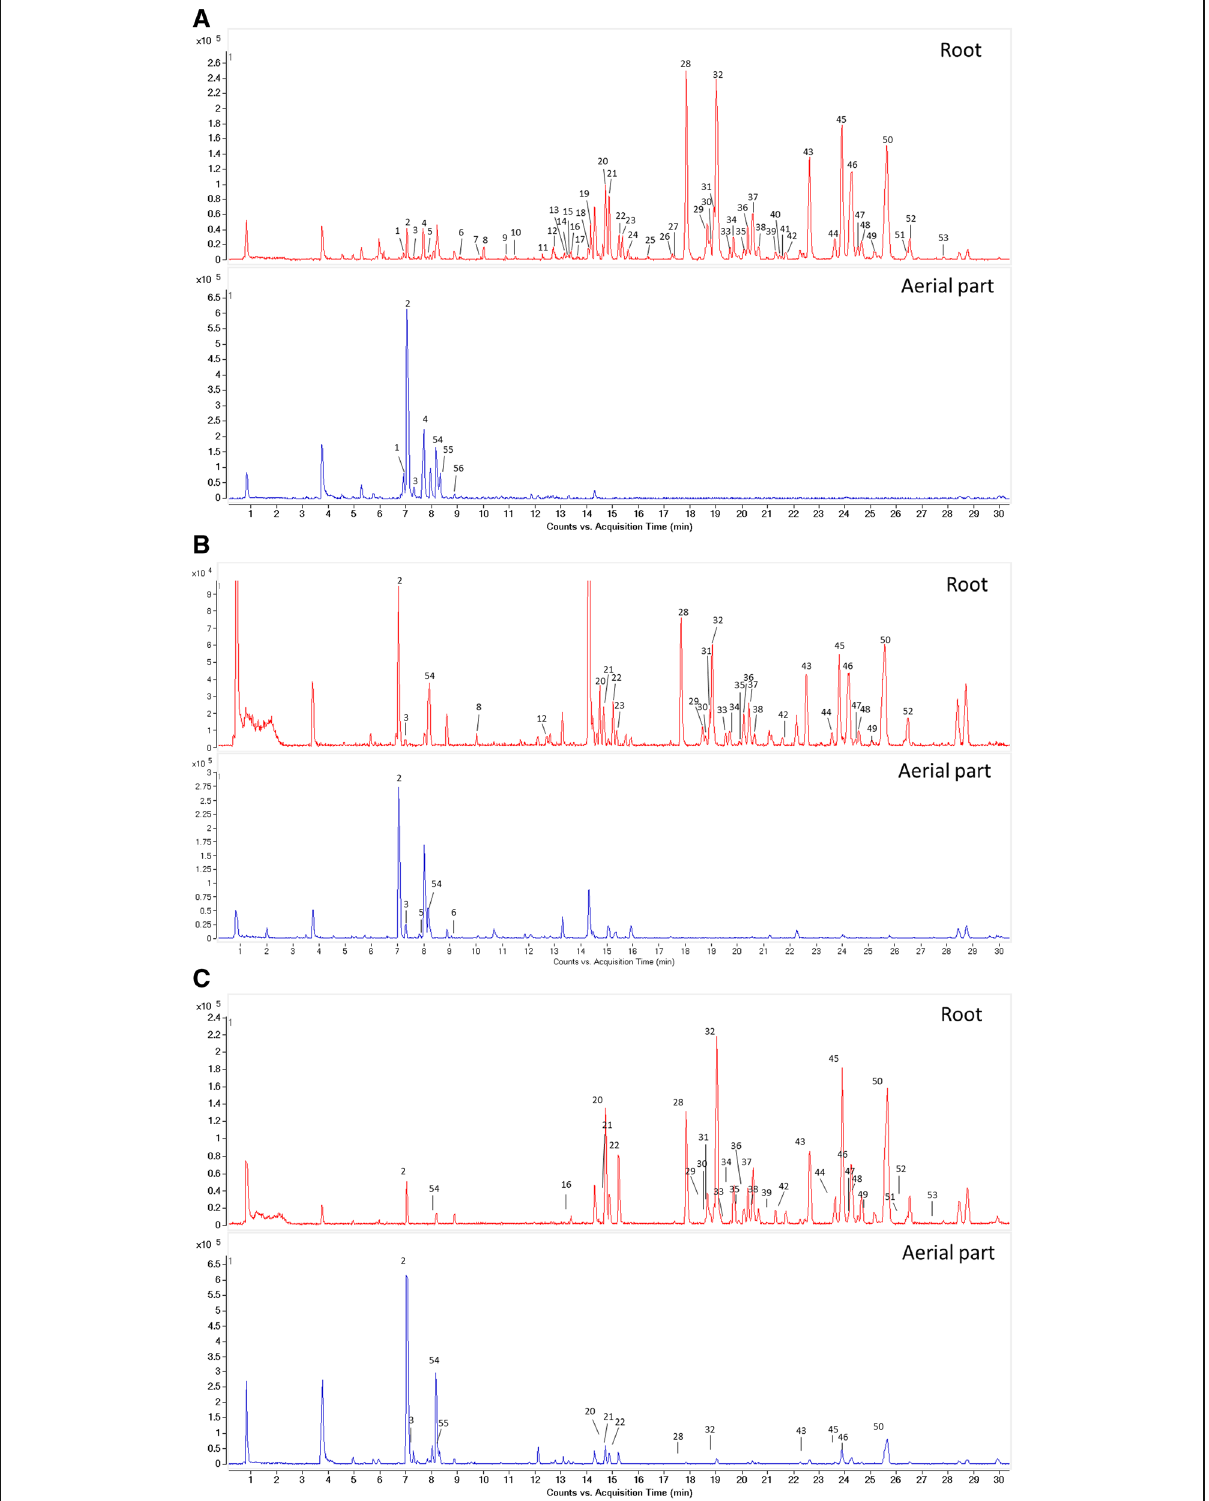
Fig. 3 The representative total ions current (TIC) chromatograms of the root and aerial parts from B. chinense DC. a , B. yinchowense Shan et Y. Li b and B. falcatum L.